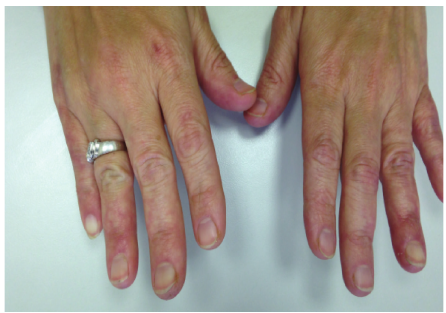
Figure 2: Following the first cycle of